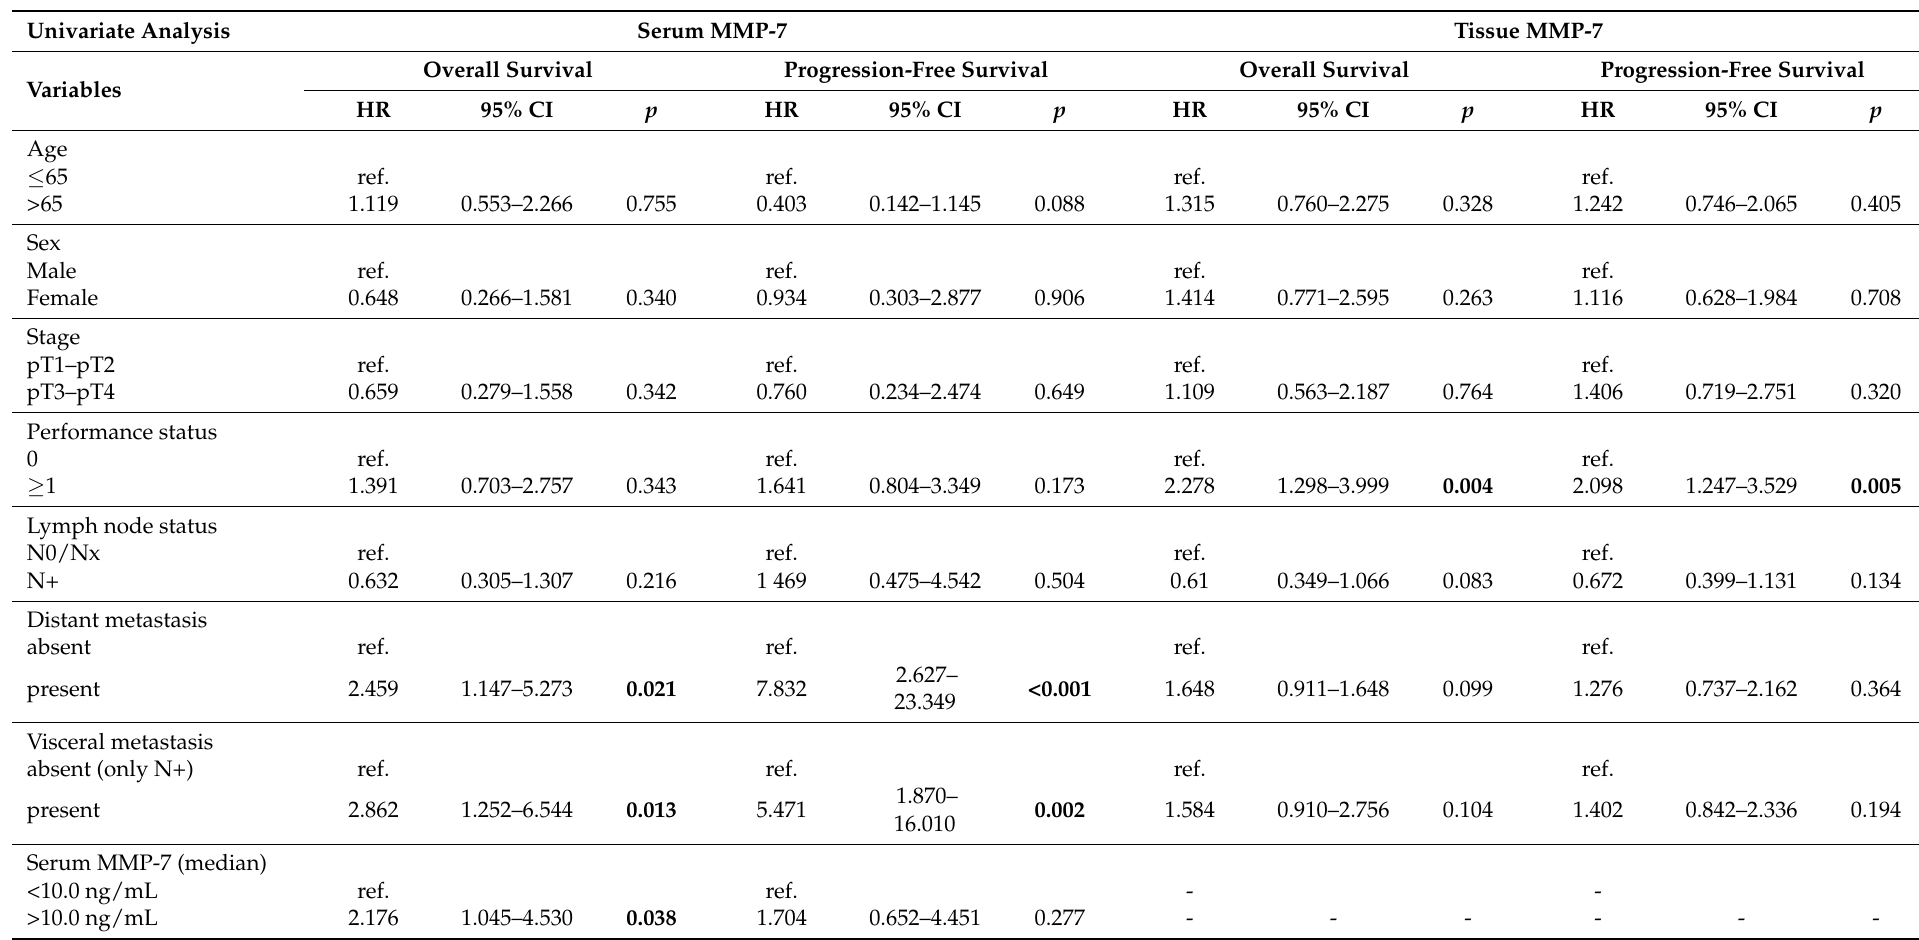
Table 3. Cox univariate overall survival (OS) and progression-free survival (PFS) analysis in the enzyme-linked immunosorbent assay (ELISA) and immunohistochemistry (IHC) cohort. Univariate